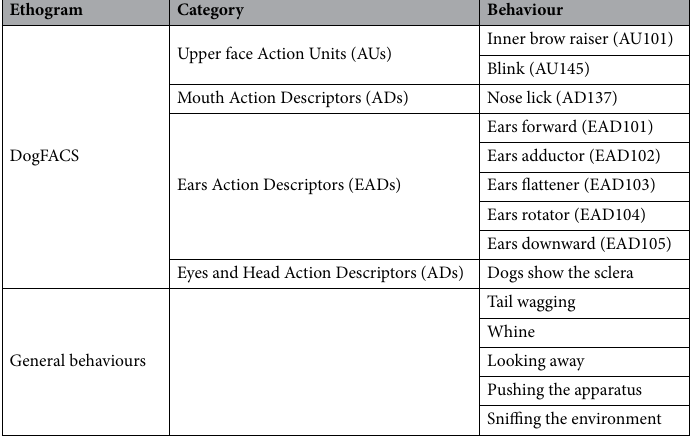
Table 1. Behaviours selected for statistical analysis.